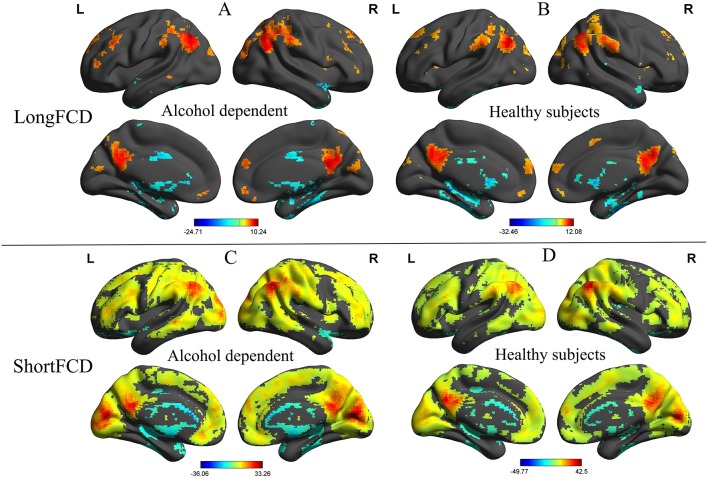
One sample t-test differences of alcohol dependent and healthy subjects in binarized FCD maps. The statistical threshold was set at FDR corrected voxel threshold of p < 0.001. Binarized longFCD (A,B) and shortFCD differences (C,D) in brain areas of patients with alcohol dependence and healthy subjects. FCD, Functional connectivity density; FDR, False discovery rate; R, right; L, left.